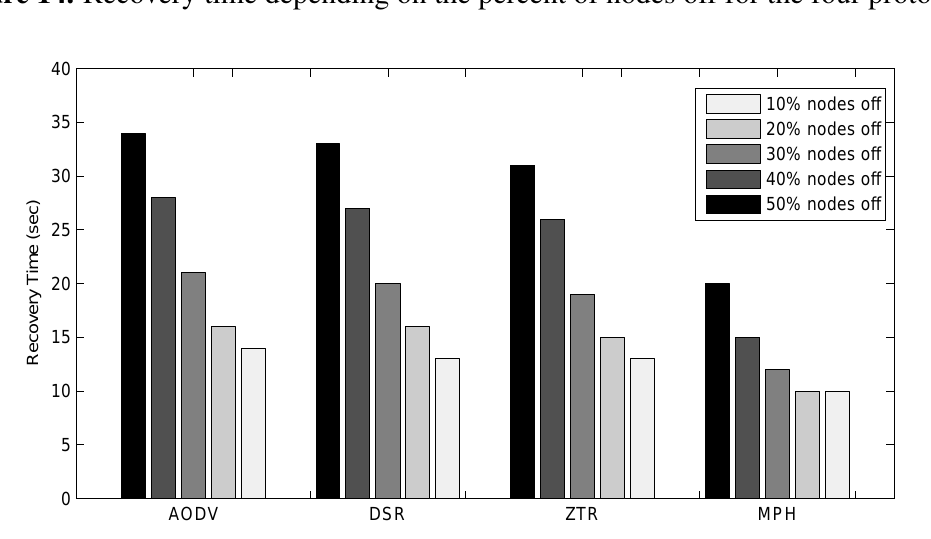
Figure 14. Recovery time depending on the percent of nodes off for the four